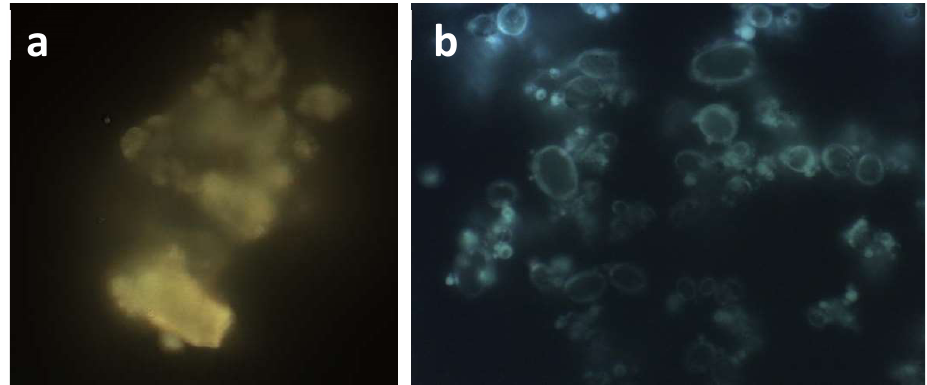
Figure 2. Fluorescence microscopy of crystalline MTE raw extract ( a ) and MTE_mp microparticles ( b )